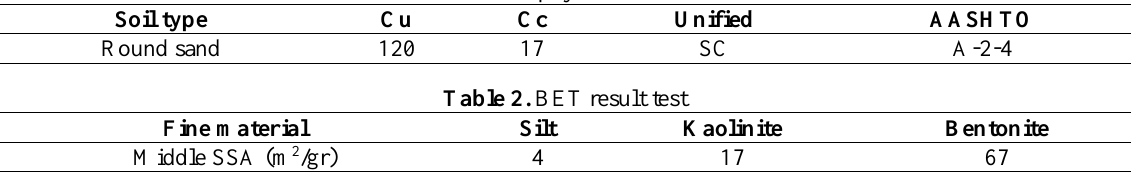
Table 1. Classification of the soils and physical characteristics of the sand materials Soil type Cu Cc Unified Round sand 120 Table 2. BET result test Fine material Silt Kaolinite Middle SSA (m 2 /gr)